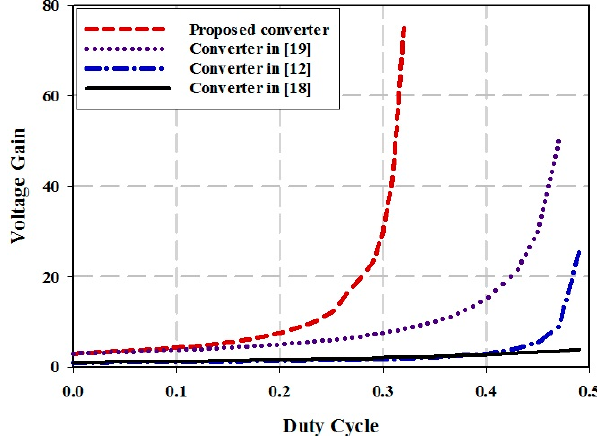
Figure 7. Voltage gain of the proposed converter vs. converters in [12,18,19].